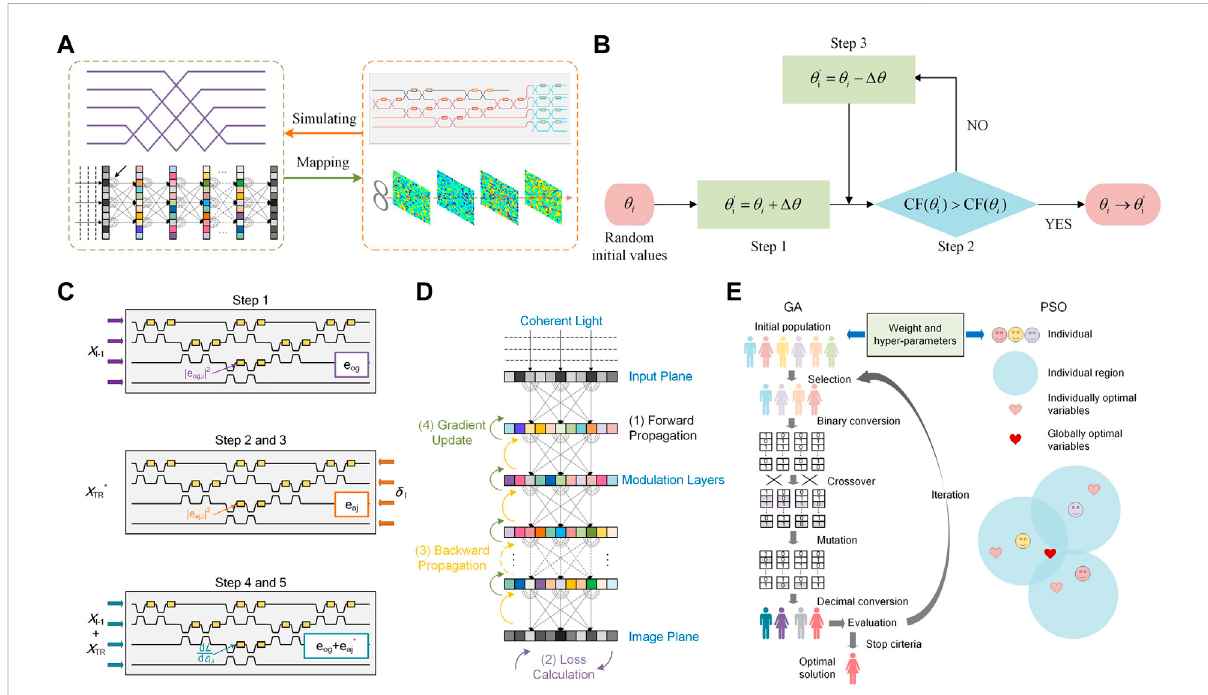
FIGURE 6 (A) The principle of the simulating and mapping (S&M) method. (B) The work fl ow of the forward propagation method for in situ training of ONNs. (C) Thework fl ow ofinsitu backpropagation and gradient measurement inMZI-based ONNs [157]. (D) The insitutraining ofdiffractiveoptical neural networks via backpropagation [159]. (E) The principle of in situ training of ONNs via neuroevolution